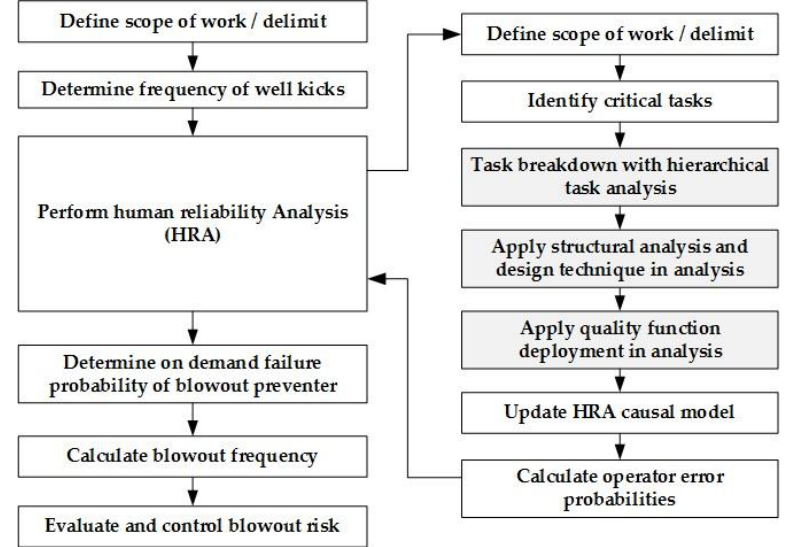
Figure 1. Procedure for the drilling probabilistic risk assessment (DPRA) of well-drilling operations (adapted from [5]).